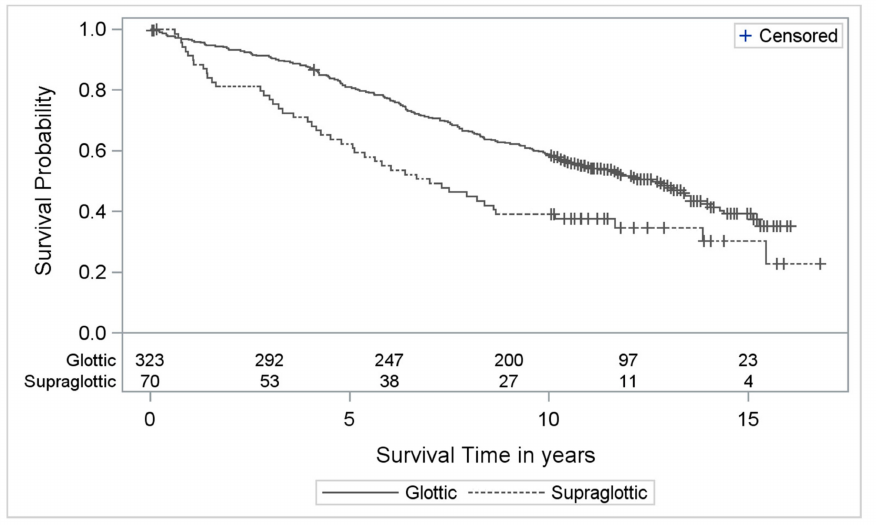
Figure 1. Kaplan Meier curves with numbers at risk of supraglottic compared to glottic cancers (T1 + T2) treated by TLM (OS) (solid line = glottic; dashed line =